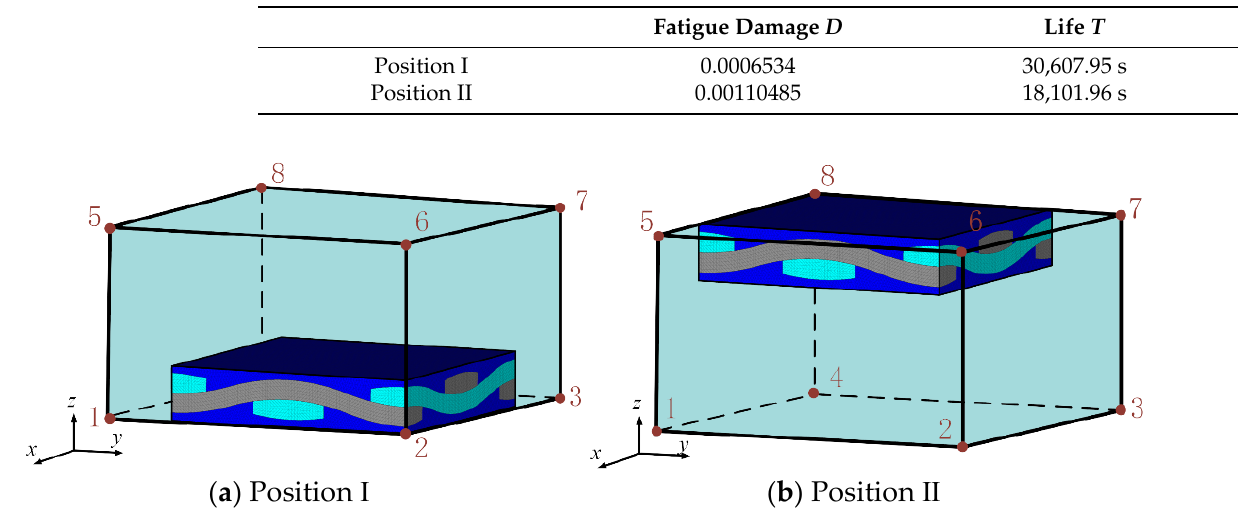
Figure 13. Different position of the sub-model in the unit.